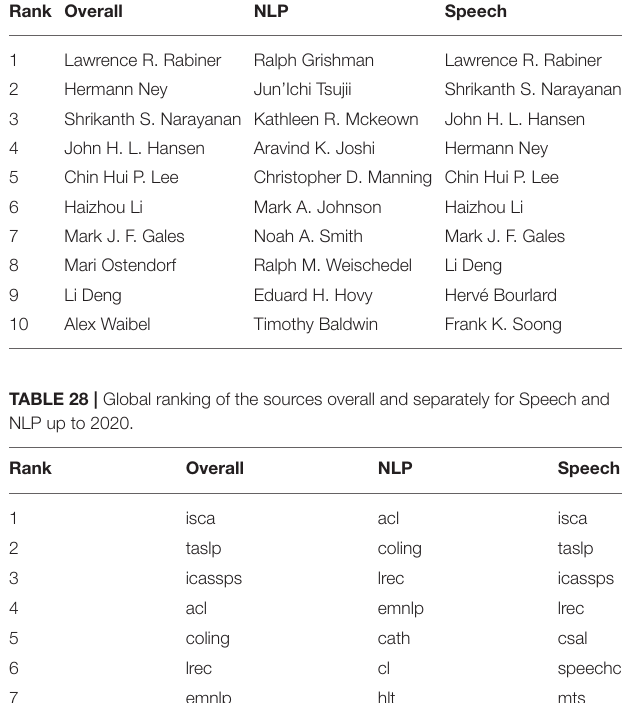
TABLE 27 | Global ranking of the authors overall and separately for speech and NLP up to 2020. Rank Overall NLP Speech